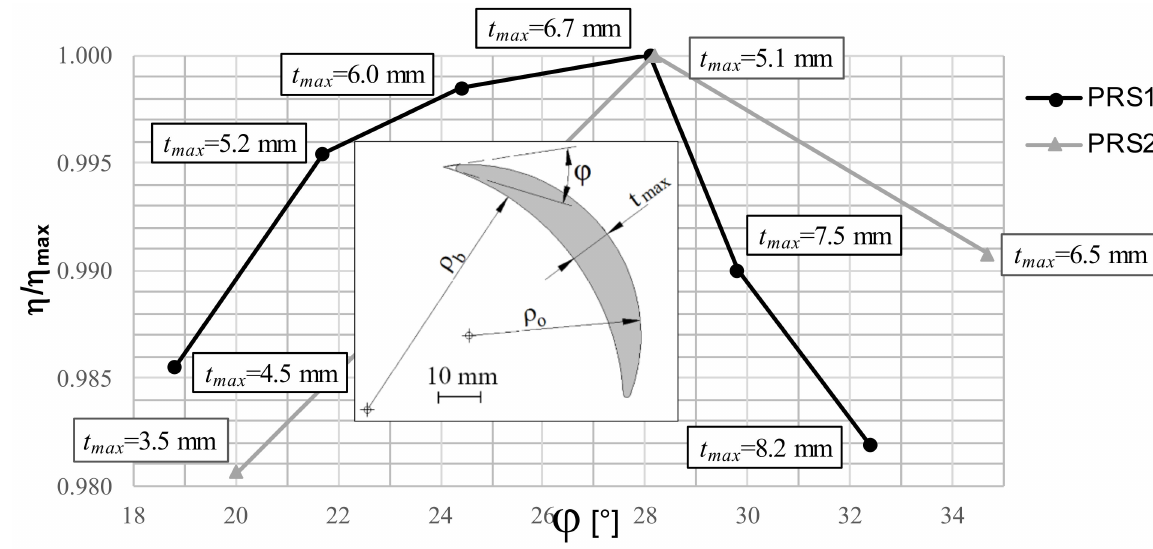
Figure 6. Efficiencies for circular outer profile.